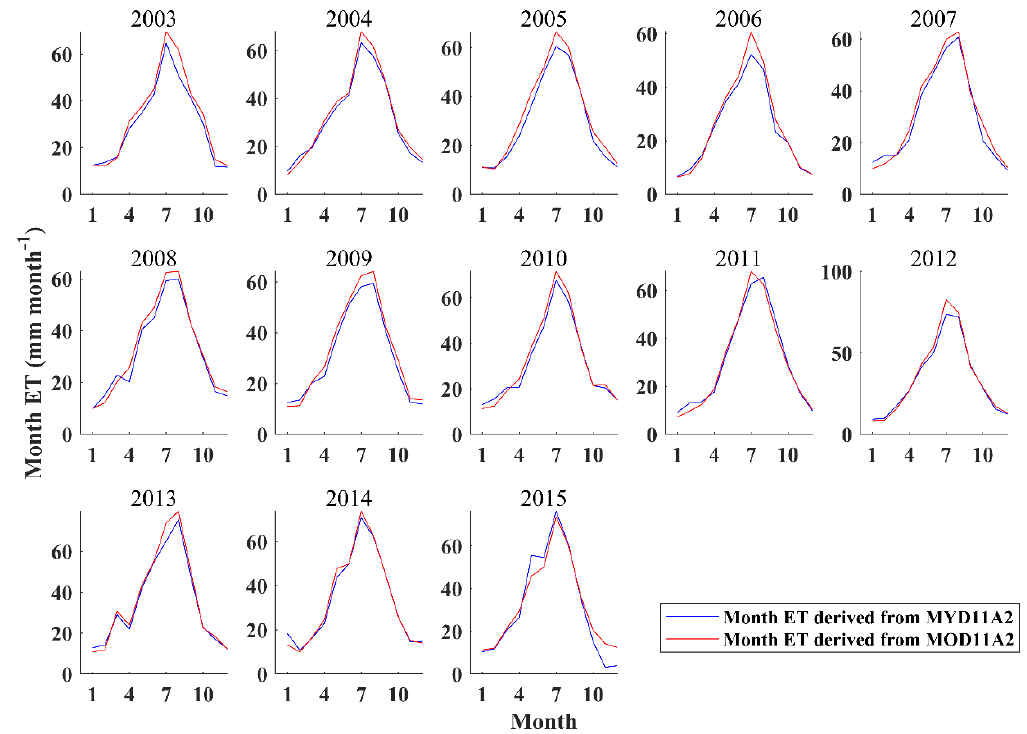
Figure A10. Monthly ET derived from the MOD11A1 and MYD11A1 in the whole YRB during the years 2003–2015.